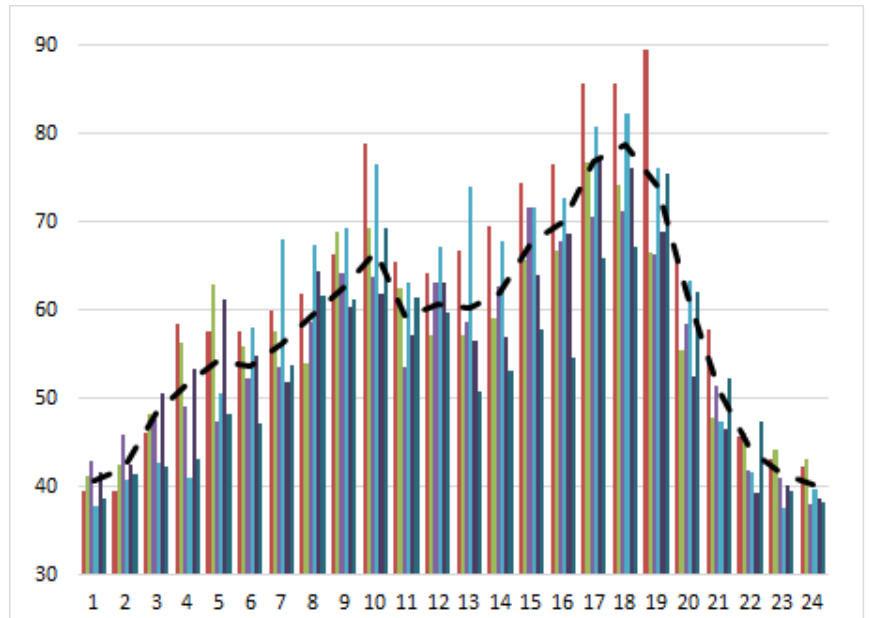
Figure 4. the load of Consumer 1 in a few days.